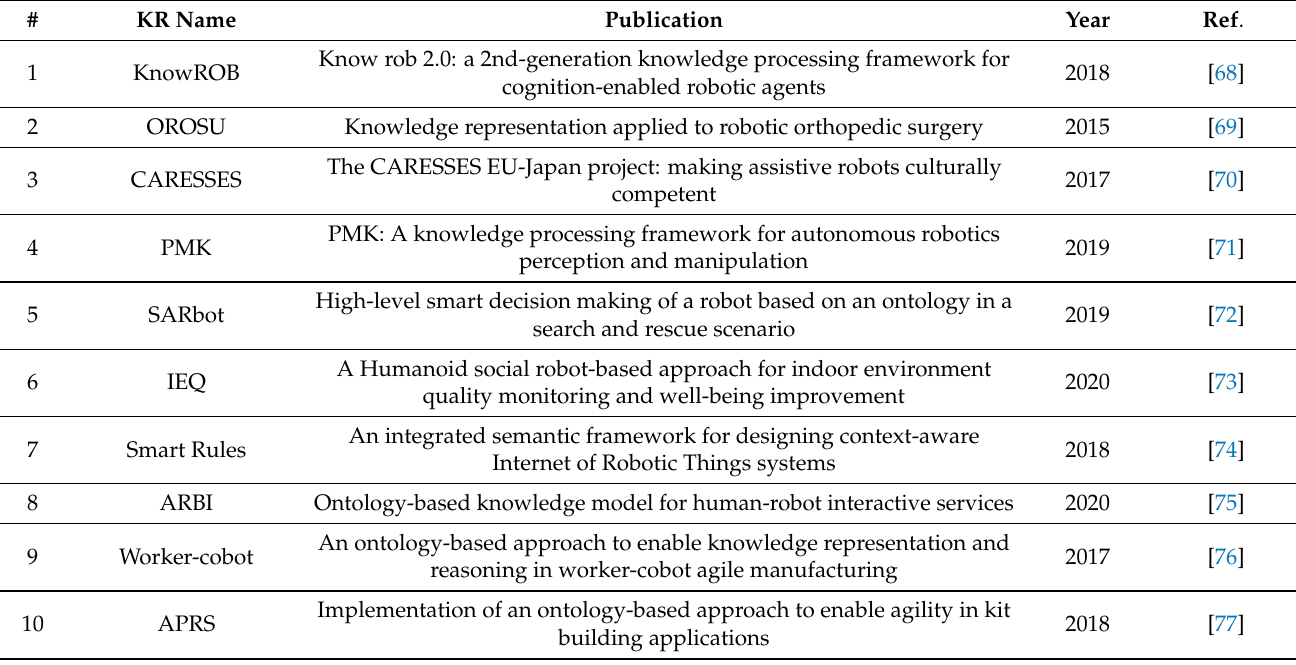
Table 1. List of selected knowledge representation systems (KRSs).